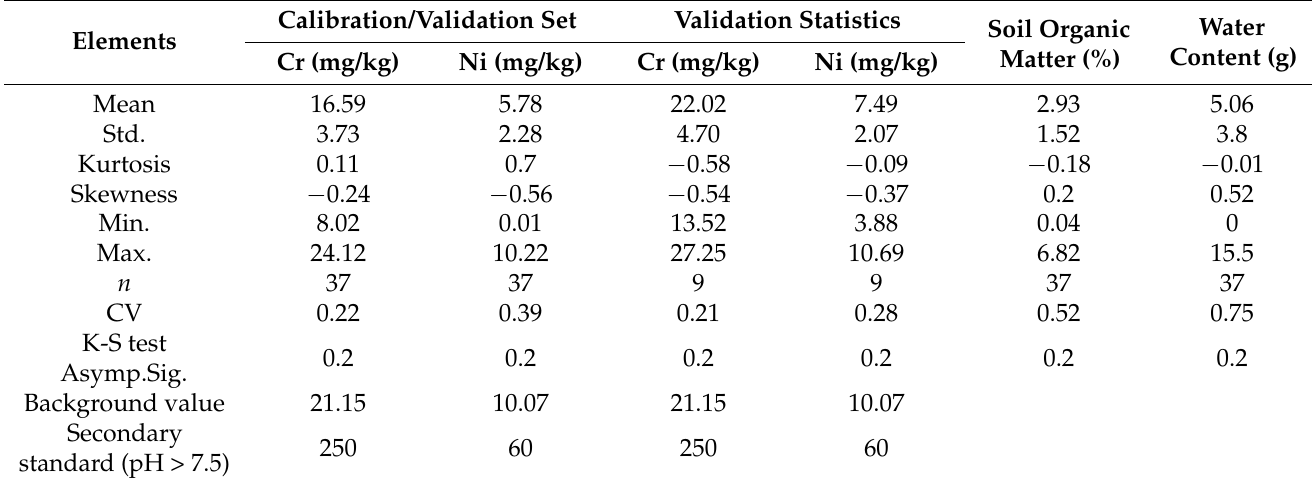
Table 2. Statistical results of heavy metal elements, SOM, and water content for soil